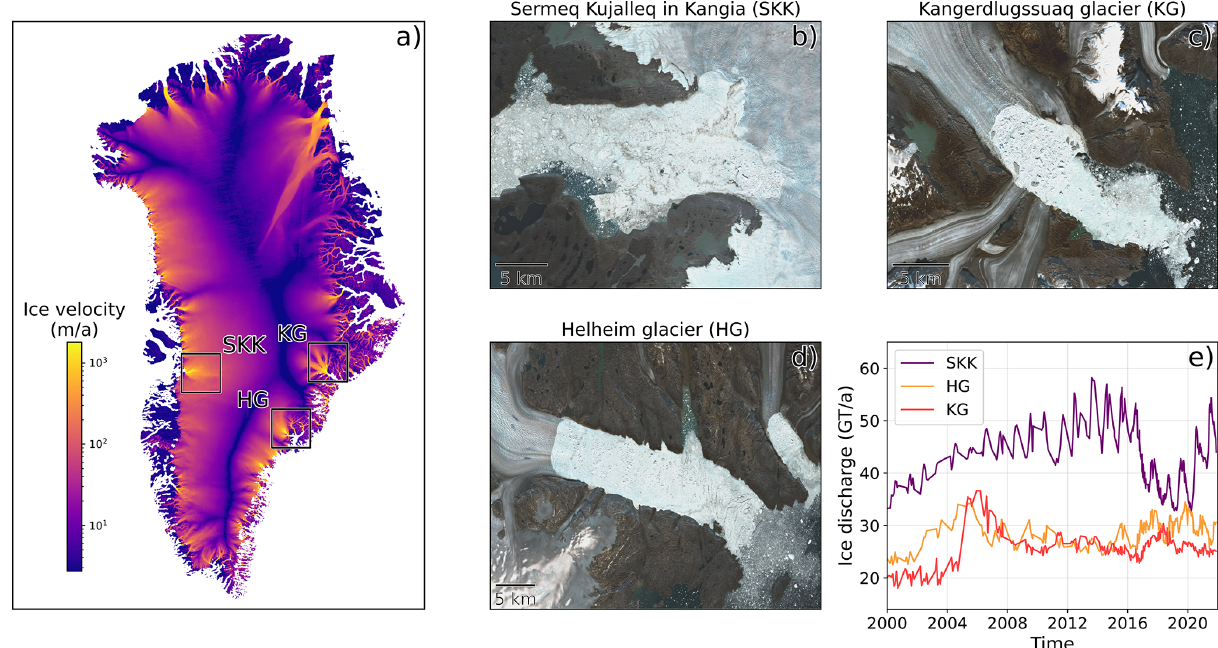
Figure 1. (a) Locations of the glaciers of interest shown on a 2020 surface velocity map of the Greenland ice sheet (Joughin, 2021). (b– d) Sentinel-2 enhanced true color images (Copernicus Sentinel data 2022, processed by ESA) of their respective calving fronts as least-cloudy mosaics in August 2020. (e) 2000–2020 respective ice discharge (Mankoff et al.,